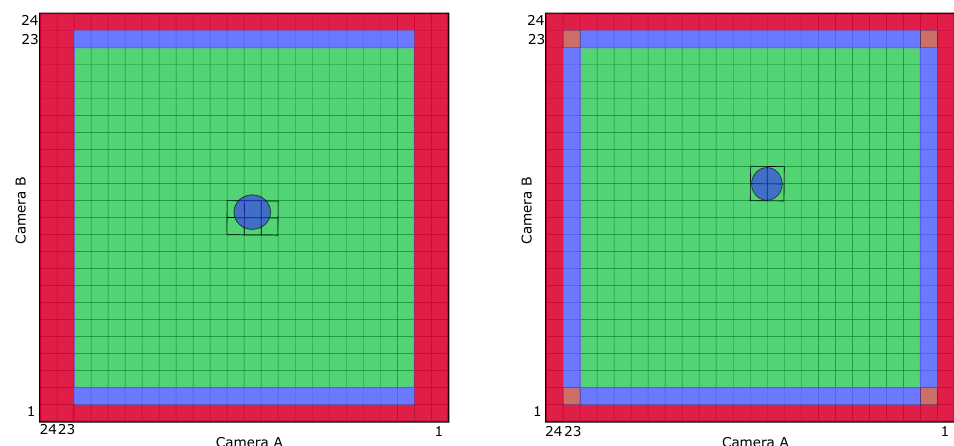
Figure 5. Similar to Figure 4, this shows the same drop falling in different locations so that it covers a 2 × 3 and 2 × 2 block of pixels, respectively. A pixel is only considered shadowed if the majority of a pixel is covered, so the left hand panel shadows a 2 × 3 region—not a 3 × 3 region. Blue shading near the boundary indicates pixels that should have half of their area included in the effective sample area computation, and orange coloring indicates pixels that should only have one fourth of their area